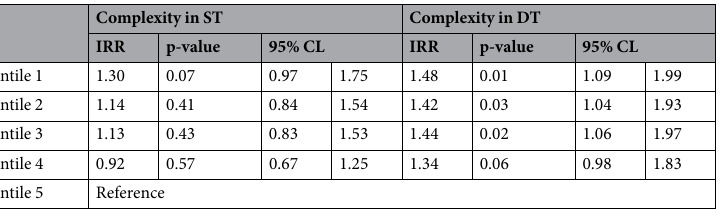
Table 5. Relationship between postural sway complexity quintiles and the rate of future falls # . # The negative binomial regression analyses were adjusted for age, sex, BMI and historical falls rate. Quintile 5 was set as the reference quintile. Note: ST = single task standing; DT = dual task standing; IRR = incident rate ratio; 95% CL: 95% Confidence